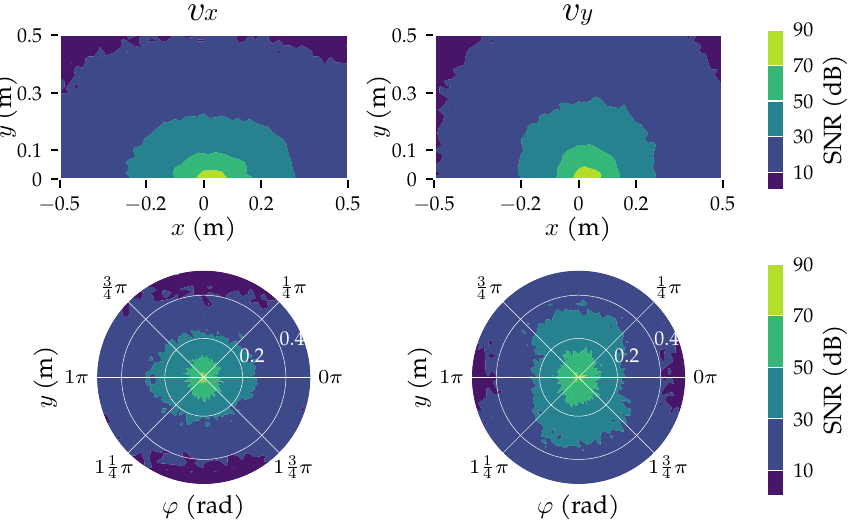
Figure 3. The signal to noise ratio (SNR) of both velocity components measured by the fifth sensor ( x = 2.86 cm). The top row shows contours of the median SNR in cells of 2 × 2 cm 2 . The bottom row shows the median SNR’s polar contours in cells of 0.02 π rad × 2cm for source states with an x -coordinate between x = − 7.14 cm and x = 12.86 cm, indicating how the movement direction of a dipole ϕ influences the SNR. Simulated potential flow measurements (Equation (1)) and the same measurements with additive Gaussian distributed noise values ( σ = 1.5 × 10 − 5 ms − 1 , µ = 0 ms − 1 ) were used to compute the SNR. Specifically, the SNR was computed as the frequency power ratio between the noisy measurements and noise floor at the source frequency ( f = 45 Hz). The frequency power was computed by a discrete Fourier transform (DFT) using a Hamming